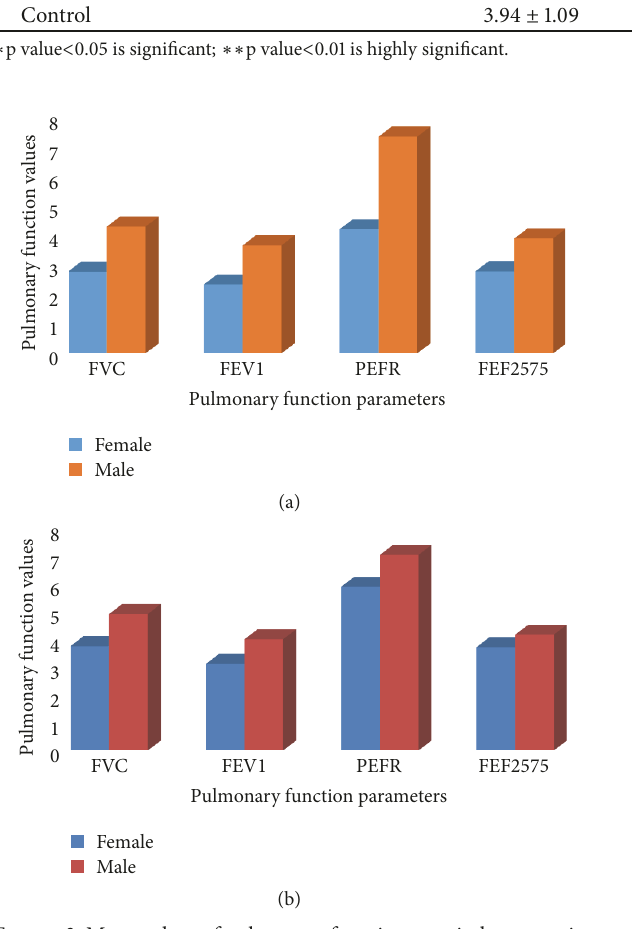
Figure 3: Mean values of pulmonary function tests in hypertensive females and hypertensivemen at Zewditu Memorial Hospital, Addis Ababa, Ethiopia,